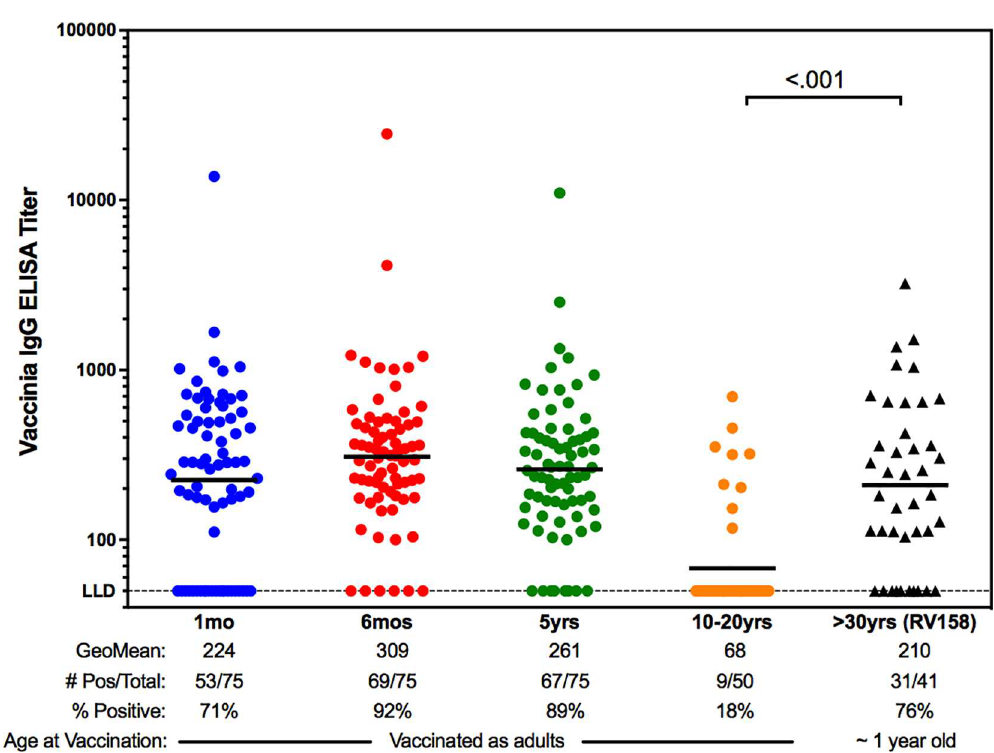
Fig 5. Influence of age at immunization on immunity duration. Anti-vaccinia ELISA titers are shown for the Dryvax ® groups of the present study of military personnelvaccinatedas adults in comparisonto results from screeningof civilian participants in a separatestudy (RV 158) who were known to be vaccinated with Dryvax ® as children(right panel). The geometric mean titers and percent positive respondersper group are indicated. Comparisonbetweenthe most distal time points from vaccinationwere done via Mann-Whitney unpairedt-test.